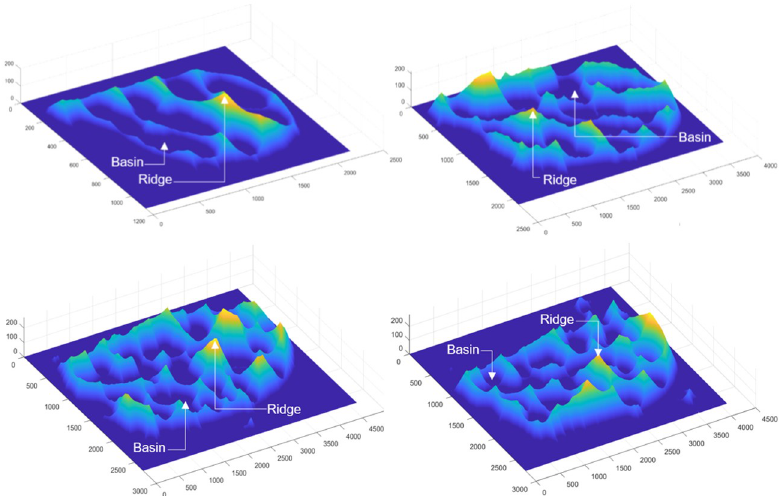
Fig 3. Zone segmentation for C. pusillus (top left), C. obsoletus (top right), C. foxi (bottom left) and C. insignis (bottom right).